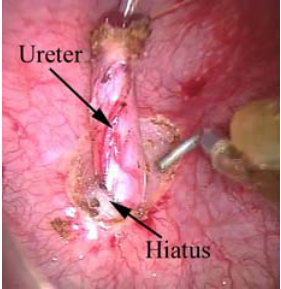
FIGURE 4. Ureteral mobilization for reimplantation during a transvesical, robotically assisted, transtrigonal (Cohen) reimplantation. The ureteral vasculature is